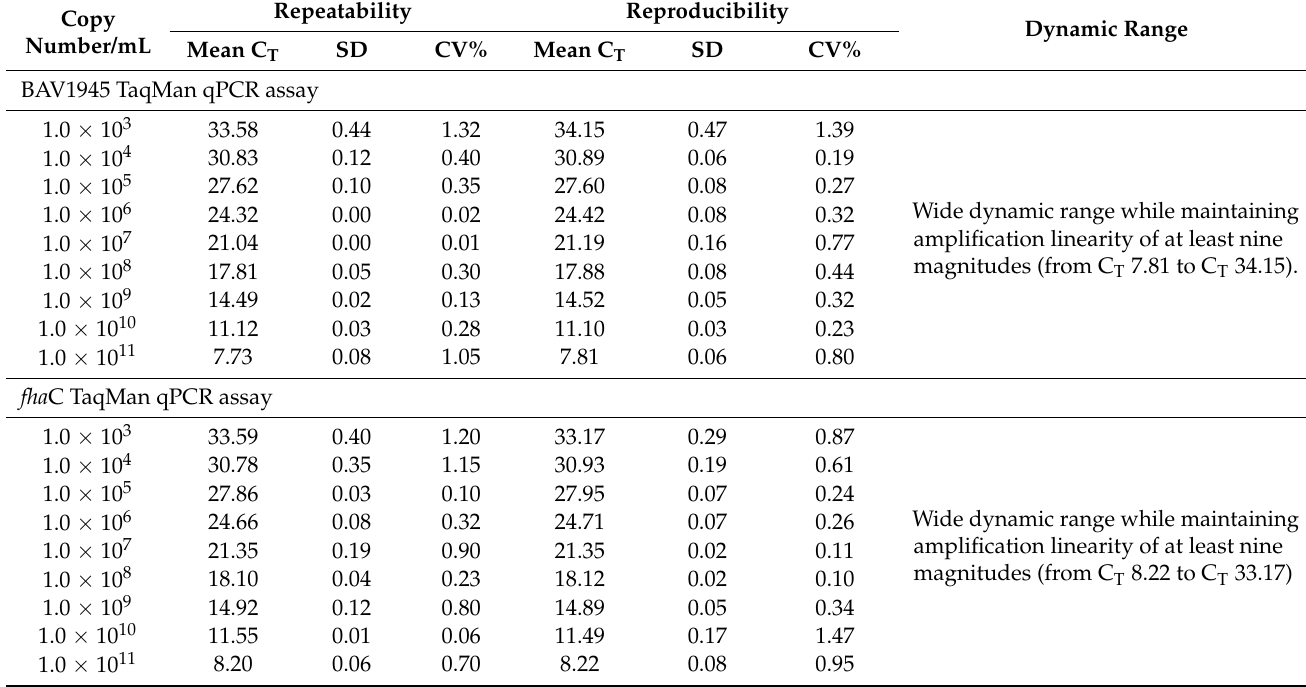
Table 5. Intra- and inter-assay variations in different concentrations of positive control DNA of the three qPCRs.